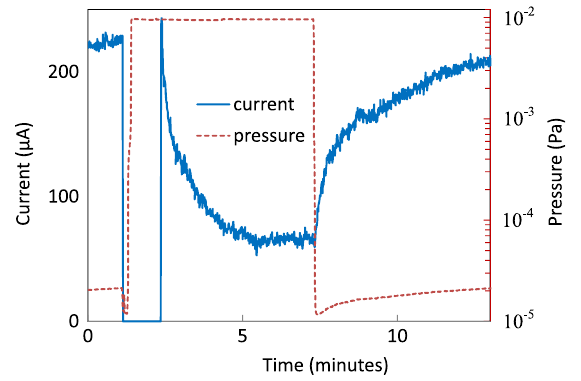
FIG. 4. Field emission current decrease for four different gases with increasing gas pressure: 2 cm gap distance, 30 kV applied